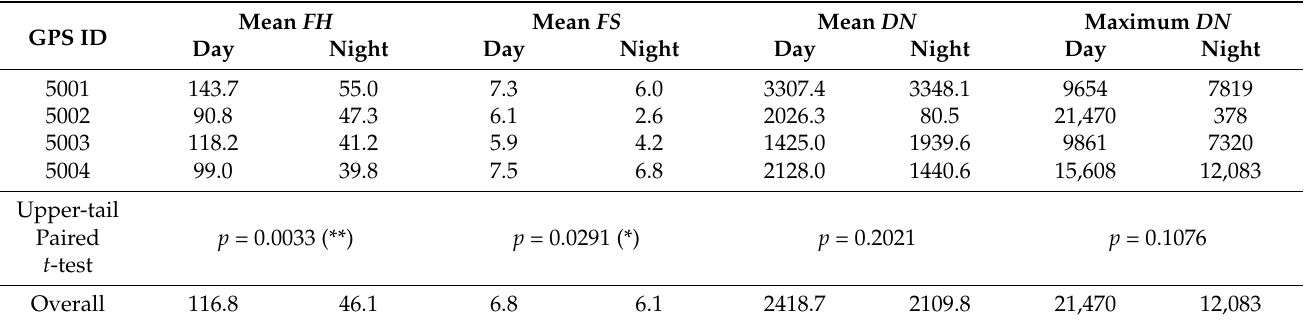
Table 2. Flight attributes of the four red-footed falcons tracked. FH : flight height above ground